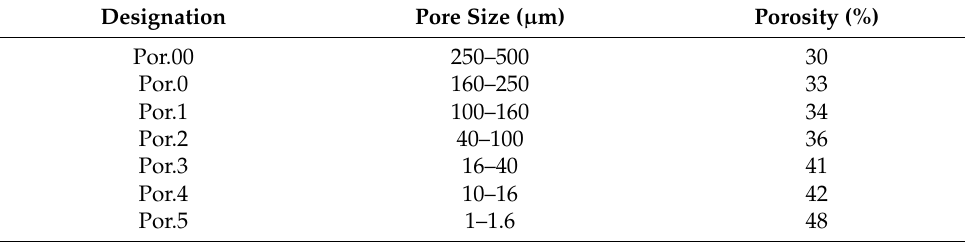
Table 1. Borosilicate classification (ISO